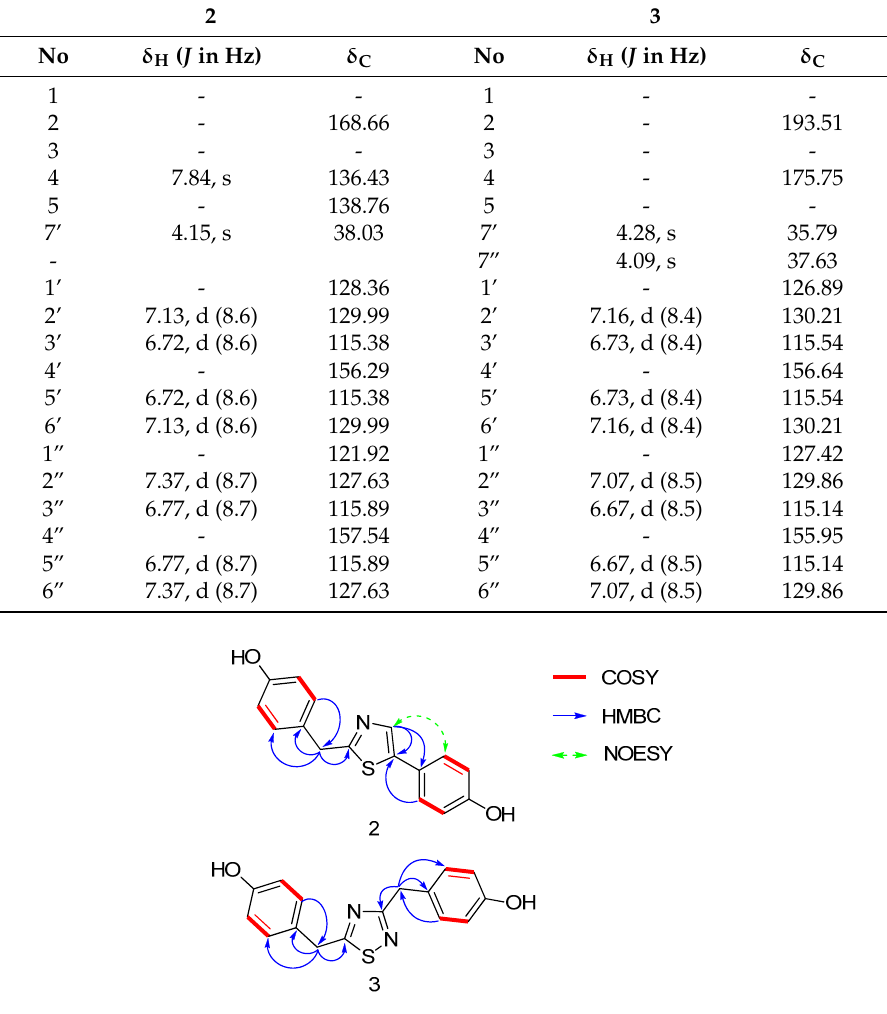
Figure 2. Selected 1 H- 1 H COSY, HMBC and NOESY correlations of 2 and 3 .